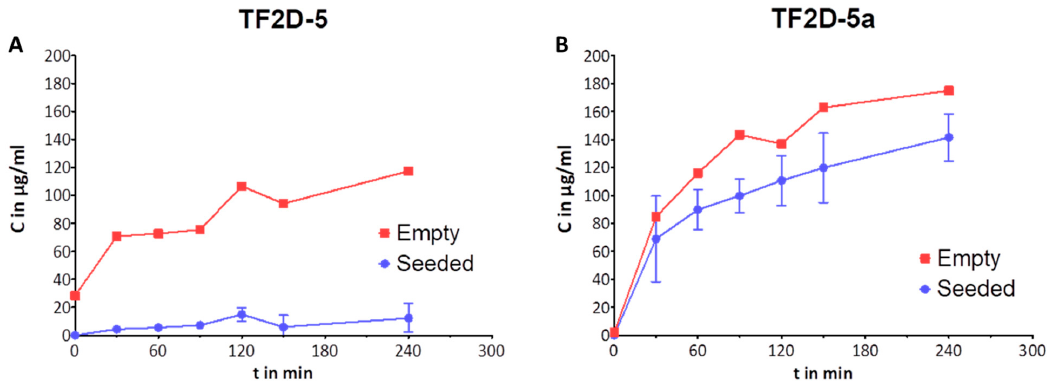
Figure 11. In vitro blood–brain barrier assay for TF2D-5 and TF2D-5a. An amount equaling 1 mg/mL TF2D-5 ( A ) or TF2D-5a ( B ) was added to an insert that was seeded and covered with endothelial and astroglial cells, representing the in vitro blood–brain barrier, or an empty insert serving as a control. After different time points, samples were taken and analyzed by quantitative HPLC analysis. Data given as mean ± SD out of three independent replicates.